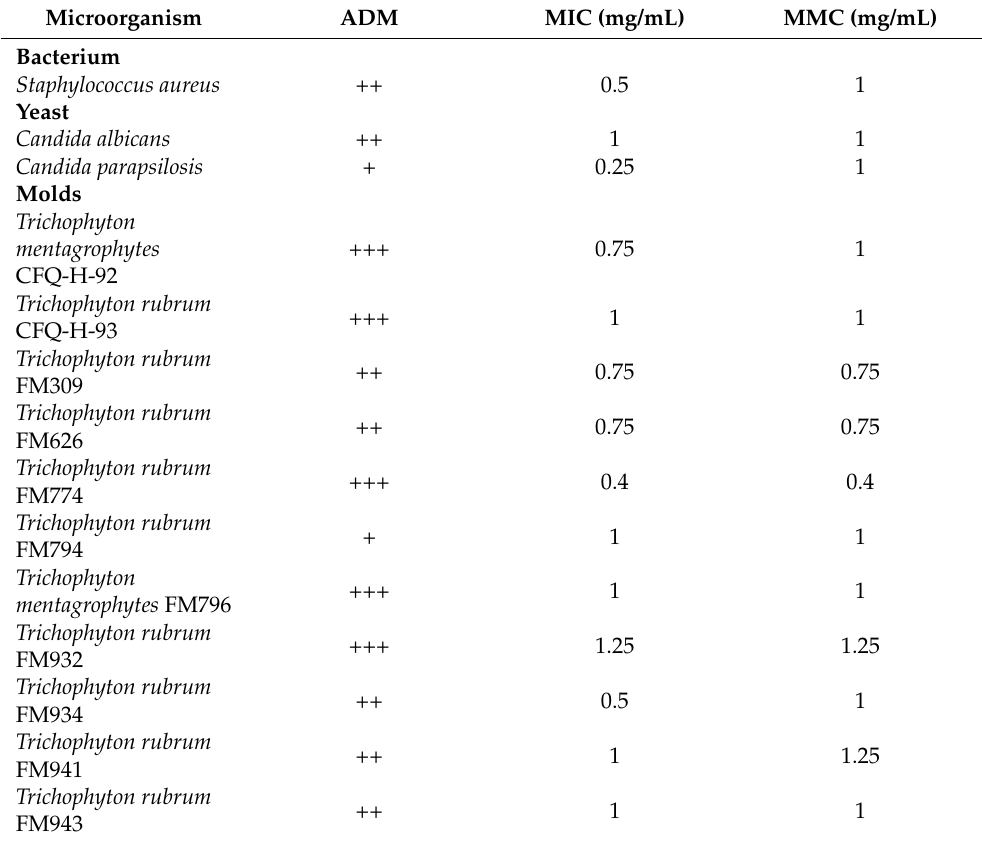
Table 1. Antimicrobial activity of Agave nuusaviorum leaf extract. Agar diffusion method (ADM), minimum inhibitory concentration (MIC), and minimum microbicidal concentration (MMC).